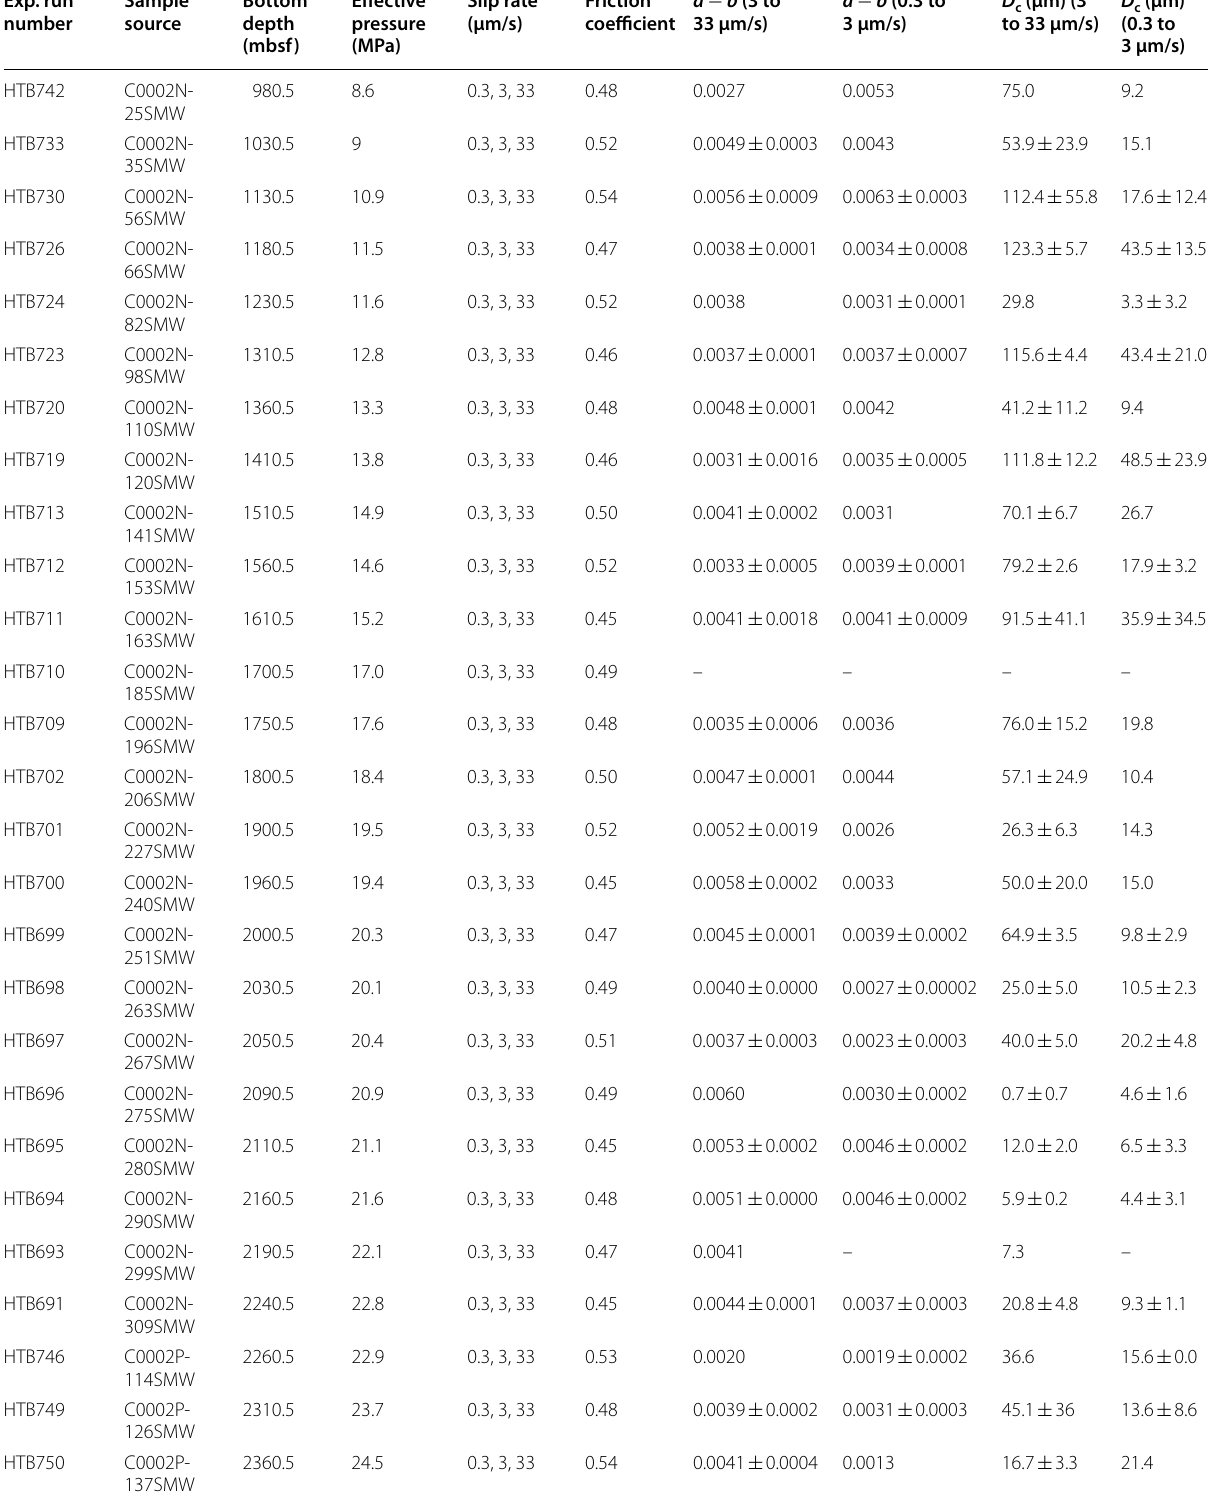
Table 1 Summary of the experimental results Exp. run